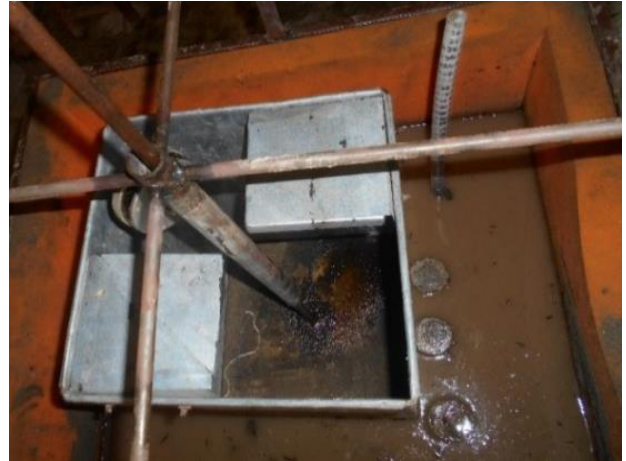
Fig. 9. Columns were intact after the application of dynamic loading Penetration of Structure inside the Ground in Treated 1-g Physical Model-II with Treatment Adjacent to Structure